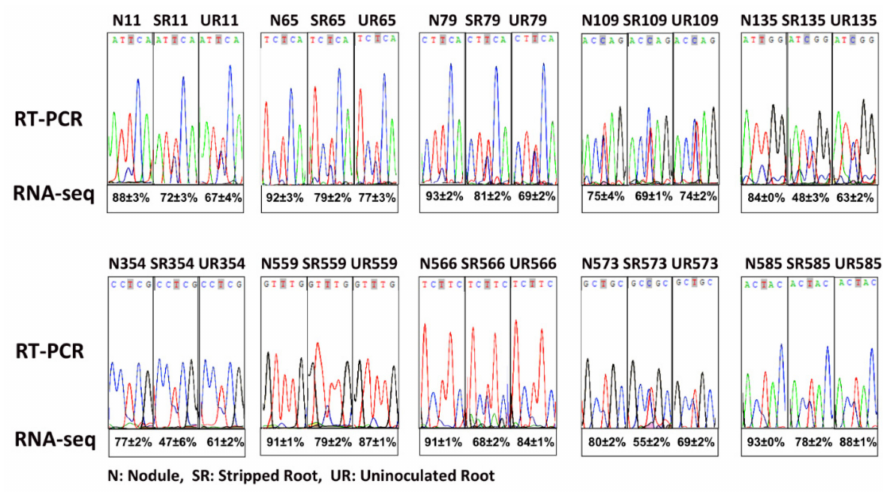
Figure 1. Validation of matR RNA editing by RT-PCR and Sanger sequencing. N, nodule, SR, stripped root, UR, uninoculated root. The numbers (e.g., N11) represented the editing site locates in the 11th amino acid codon of the GlmaxMp73 ( matR ) transcript. The average percentages (with SD values) of RNA editing of three biological replicates obtained by RNA-seq are shown below the Sanger sequences.